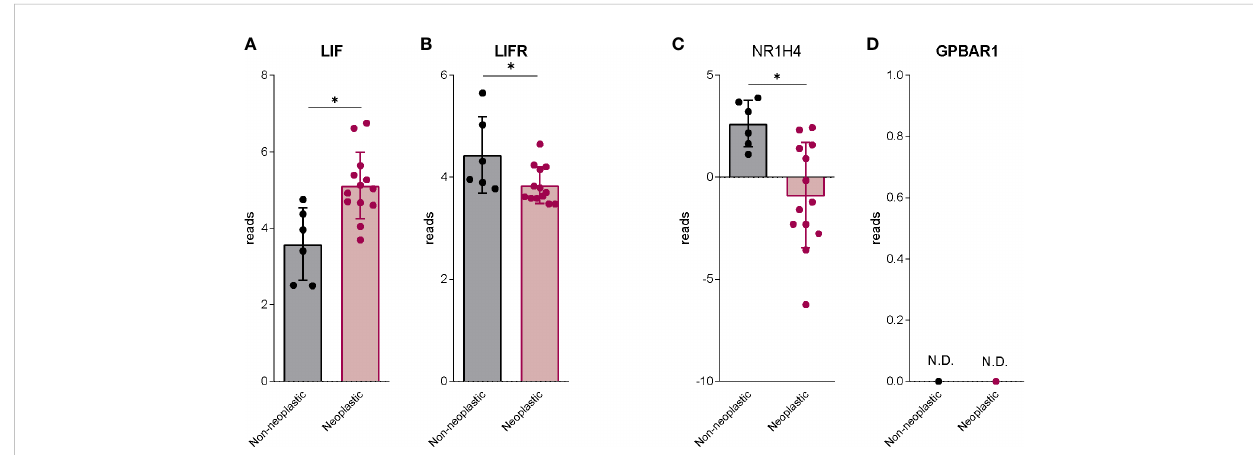
FIGURE 1 The bile acids receptors expression is downregulated in human PDAC. RNA-seq analysis of non-neoplastic and neoplastic mucosa of PDAC from GSE196009 repository. Each dot represents a patient. Data shown represent the gene pro fi le expression of (A) LIF, (B) LIFR, Nuclear